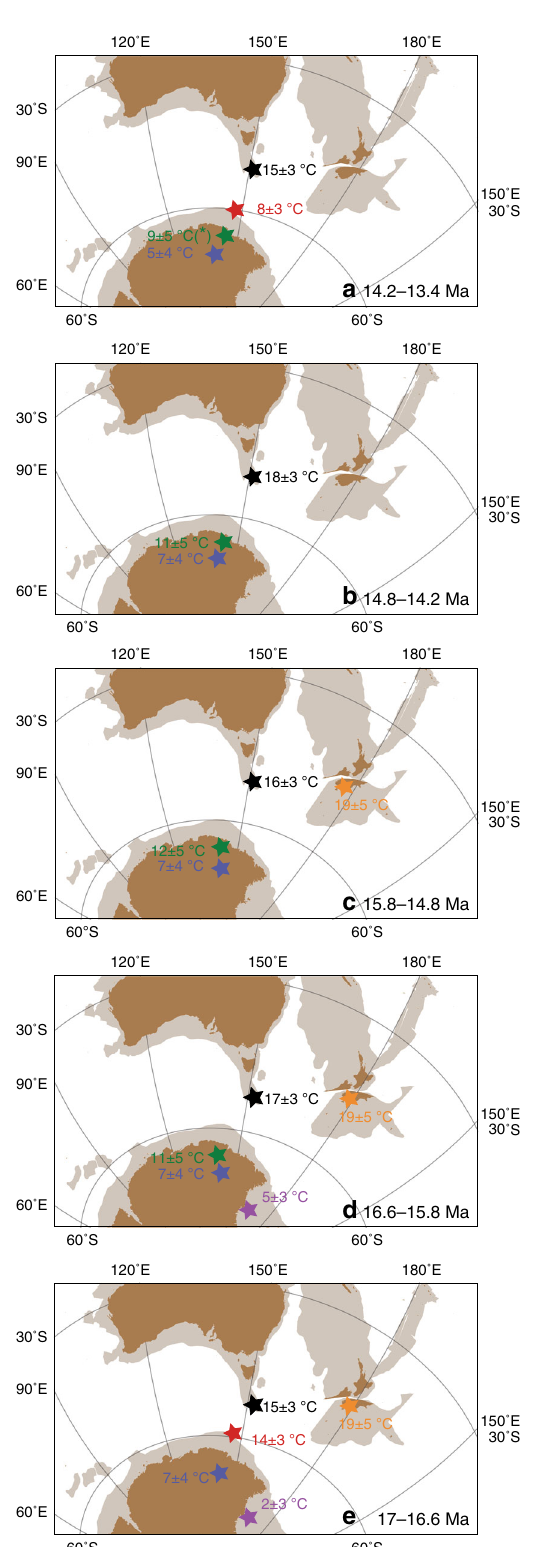
Fig. 4 Southwest Paci fi c Latitudinal temperature gradient evolution